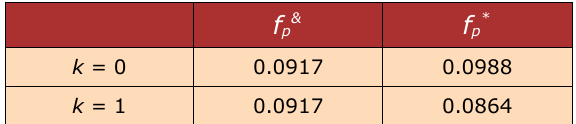
Table 2. The impact of compatibility on optimal qualities under case II and case